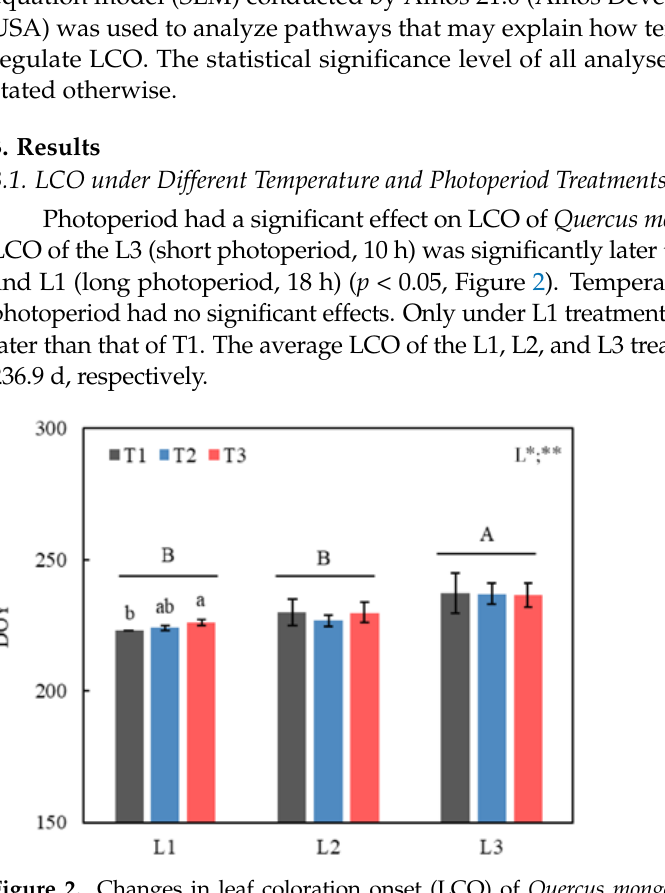
Figure 2. Changes in leaf coloration onset (LCO) of Quercus mongolicus seedlings under the temperature and photoperiod treatments. Error bars represent means ± SE ( n = 4). DOY represents day of year; T1 represents control; T2 represents 1.5 °C warming; T3 represents 2.0 °C warming; L1 represents 18 h photoperiod (long photoperiod), L2 represents 14 h photoperiod (control), and L3 represents 10 h photoperiod (short photoperiod). The different uppercase letters show significant differences among photoperiod treatments ( p < 0.05), and the lowercase letters show significant differences among temperature treatments ( p < 0.05). * and ** were used to indicate significant differences in temperature (T) and photoperiod (L) and their interaction effect at p < 0.05 and p < 0.01, respec-